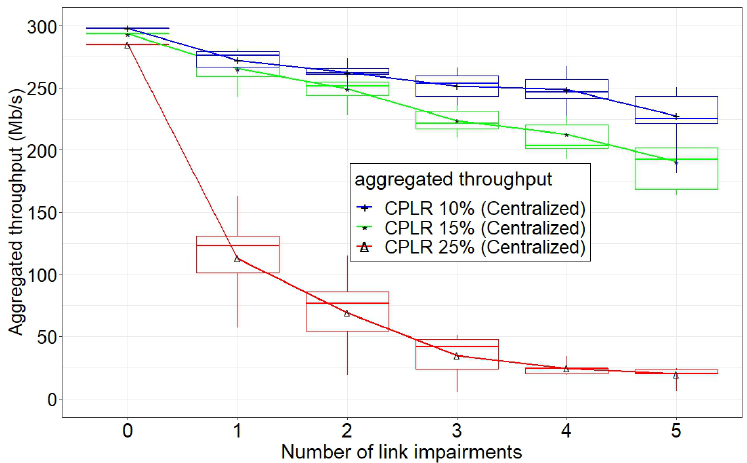
Figure 10. Aggregated throughput behavior of centralized network operation during data plane link failures for various times under unreliable control plane conditions in a 16-node grid